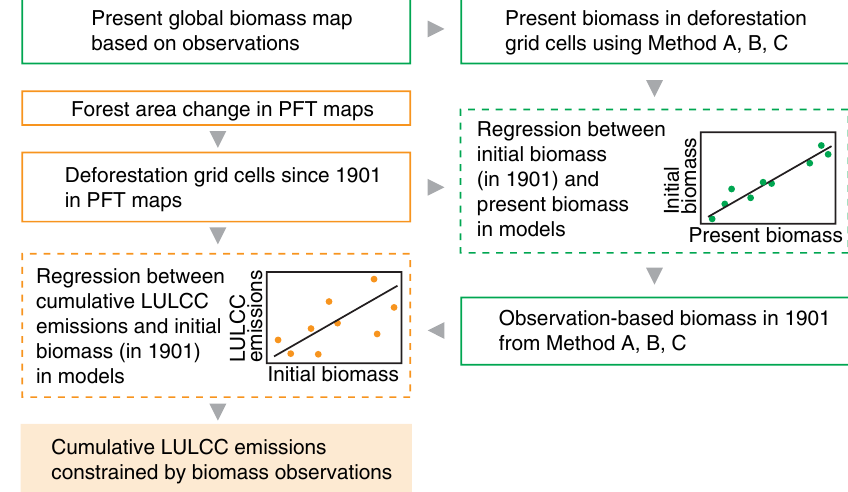
Figure 1. The framework of this